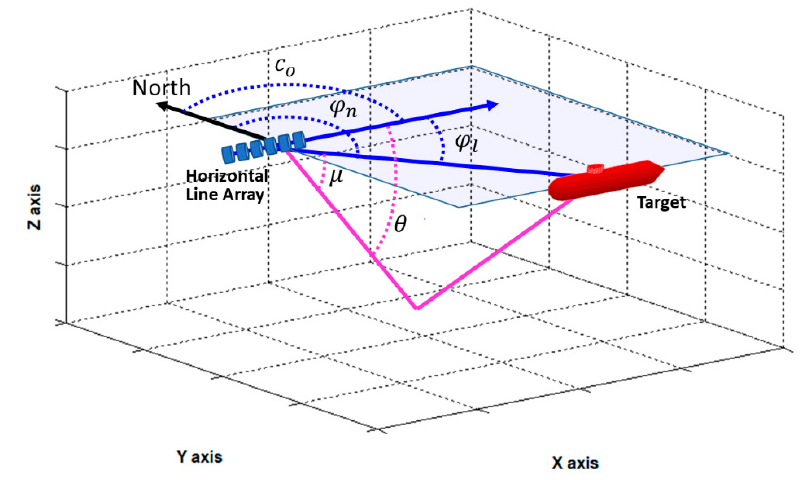
Figure 2. Geometry between observer and target. ϕ l and ϕ n are the azimuth angles from due north and the direction of the HLA, respectively. c o , θ , and µ are heading angle of the HLA, conical angle, and elevation angle in the vertical plane, respectively.